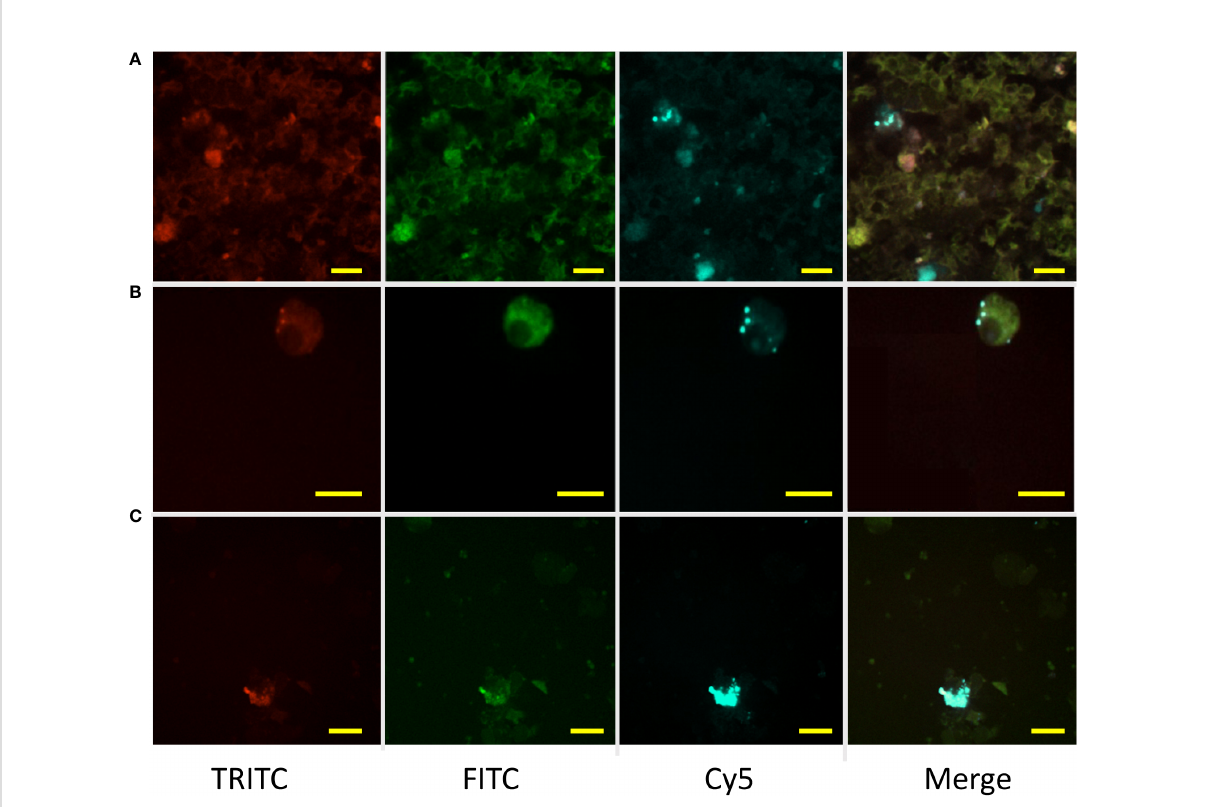
FIGURE 5 Retention of experimentally injected labeled antigen by MM F s. Leukocytes were isolated from gold fi sh or zebra fi sh spleen and kidney 14 days after immunization with BSA-Alexa-647. Red (TRITC) and green (FITC) are MM F auto- fl uorescence, while BSA-Alexa 647 is seen in the Cy5 channel. Distinct blue spots in the merged image indicate the signal from Alexa- fl uor 647. (A, B) Kidney and spleen leukocytes isolated from immunized gold fi sh. (C) Kidney leukocytes isolated from zebra fi sh immunized with Alexa-647. Scale bars are 10 µm.